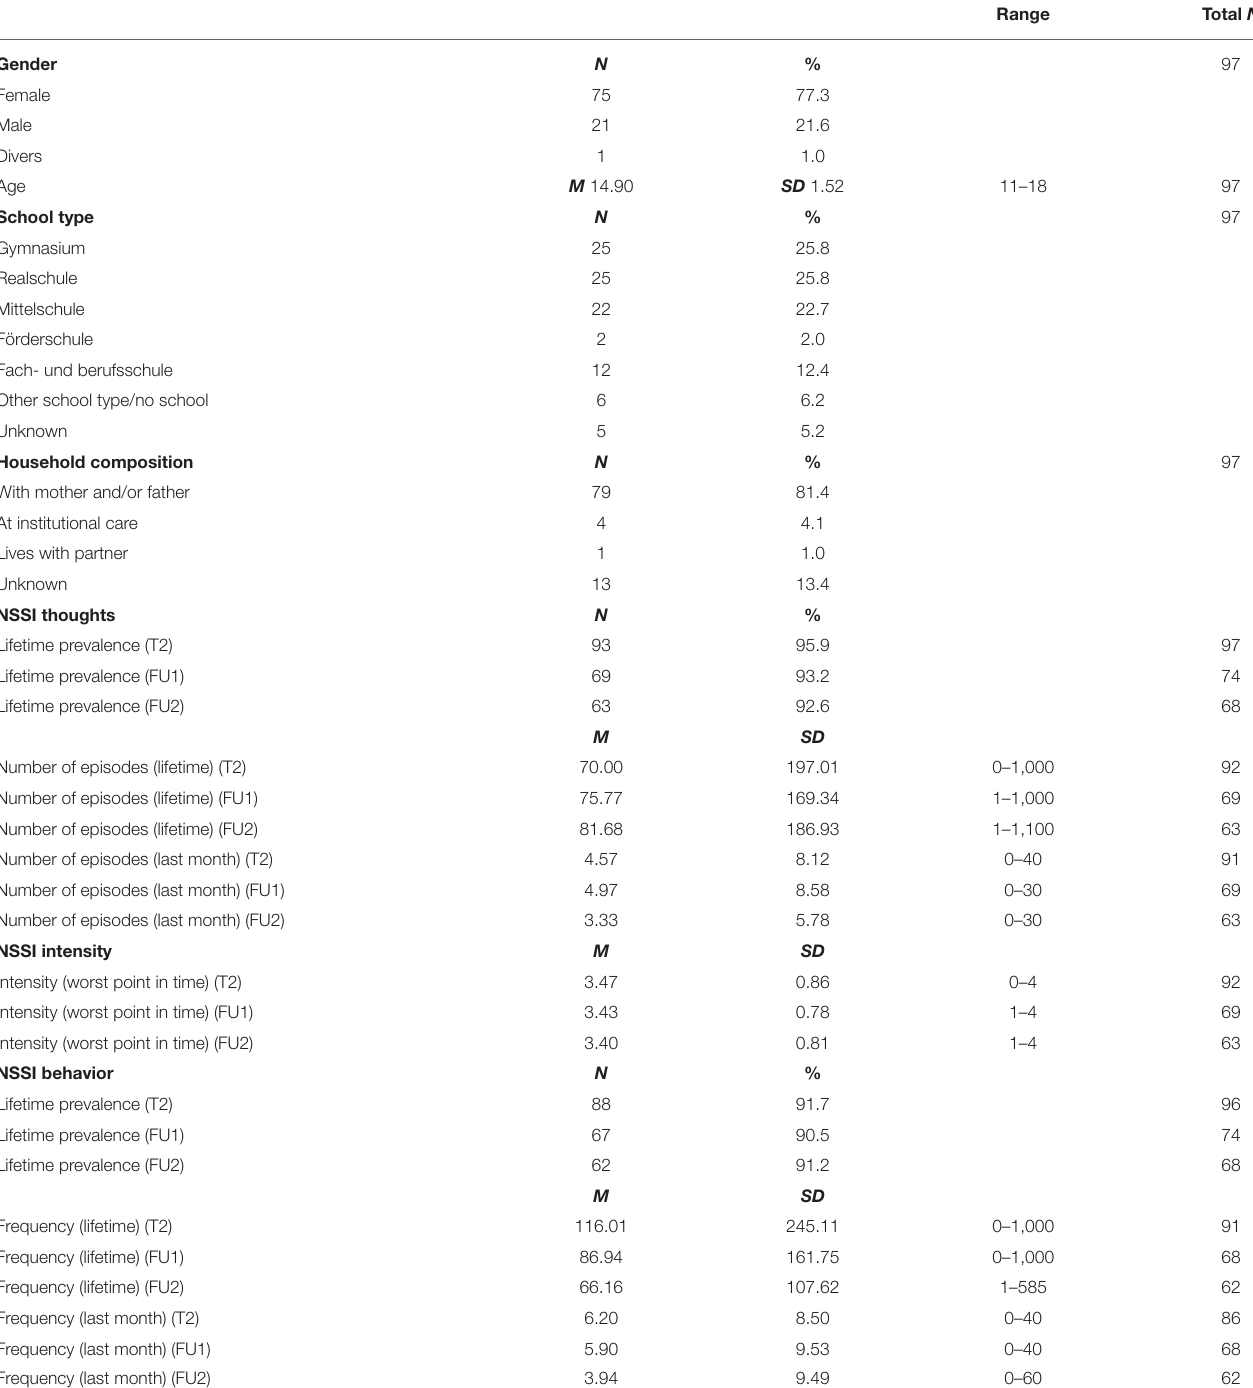
TABLE 1 | Sociodemographic and clinical characteristics of